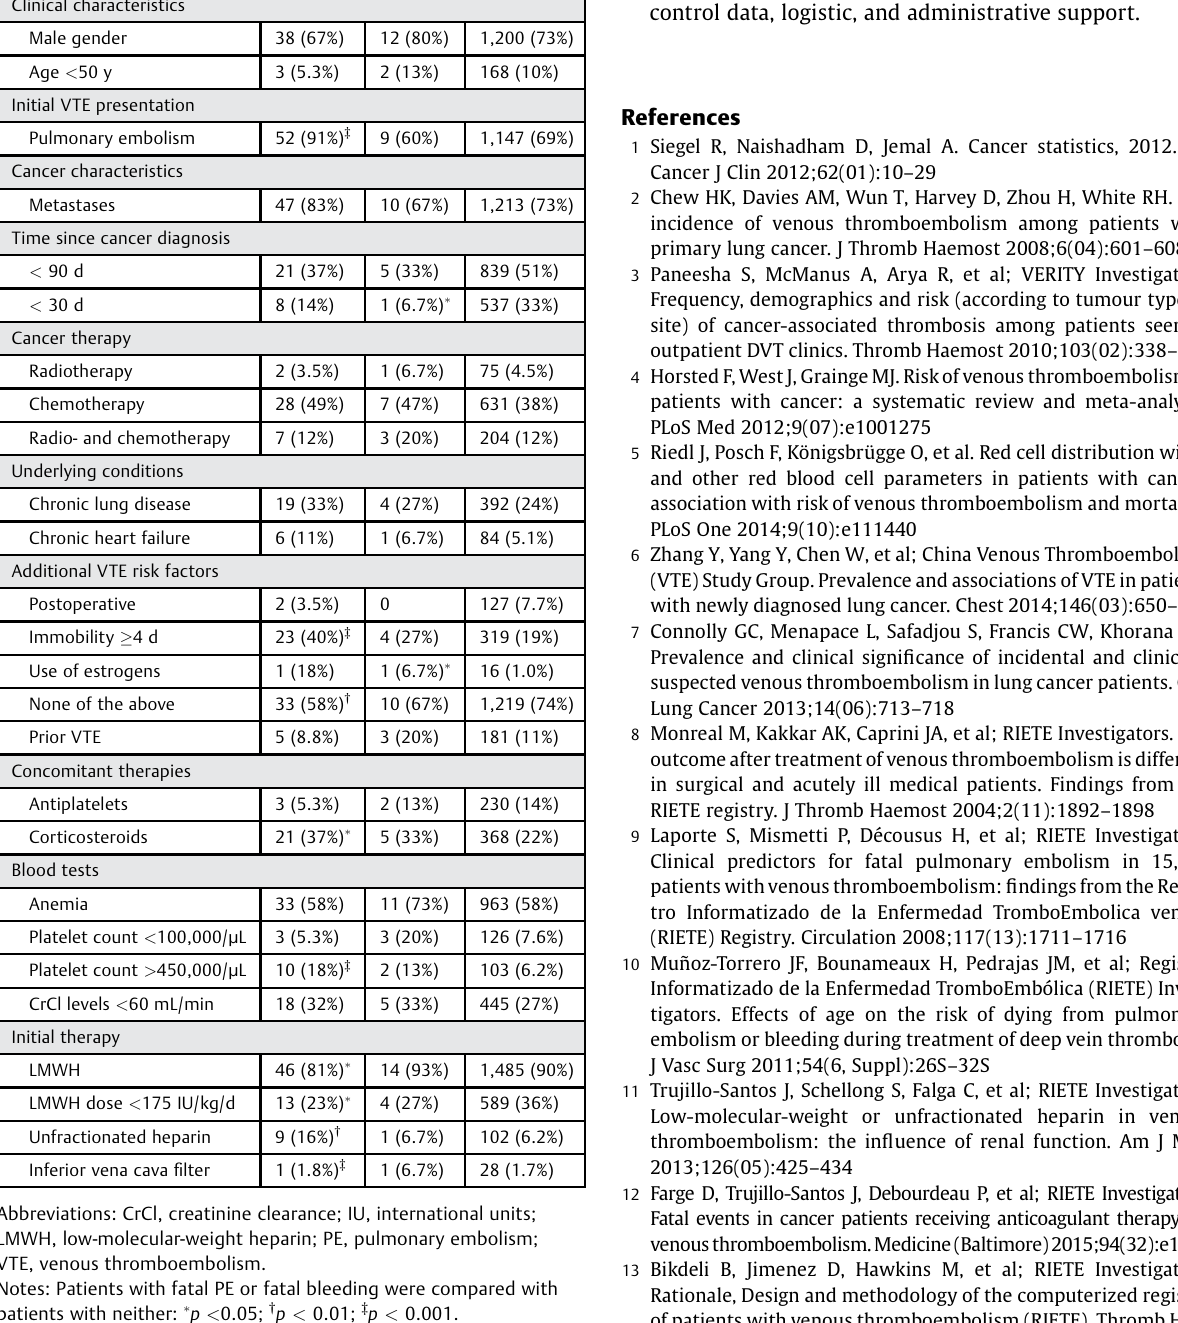
Table 4 Clinical characteristics of patients who died of PE or bleeding Patients ,